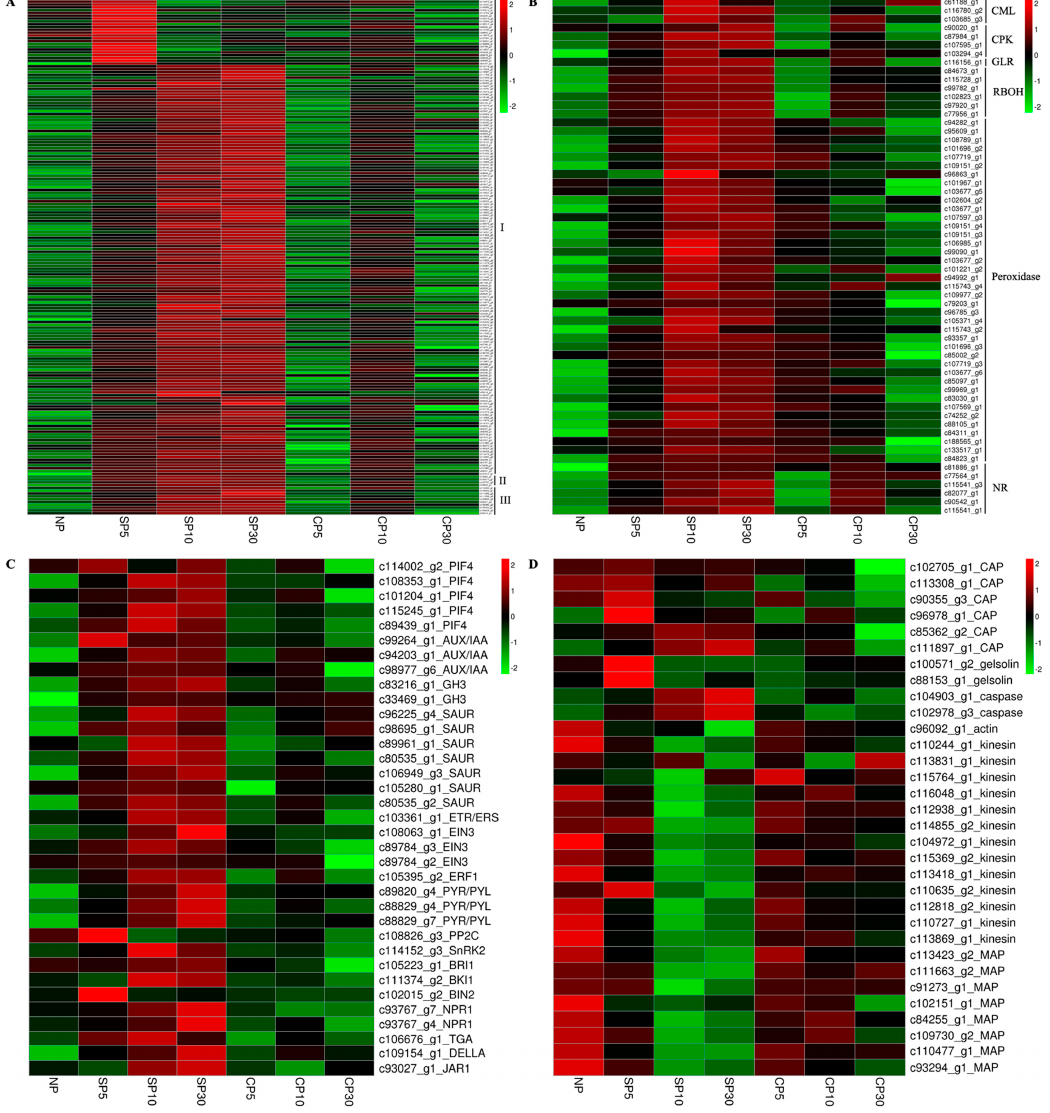
Figure 7. Expression profiles of selected SI response gene categories. ( A ) Protein phosphorylation (I) and putative pollen (II)–stigma (III) recognition-related genes. ( B ) Calcium (Ca 2+ ), reactive oxygen species (ROS), and nitric oxide (NO) signaling-related genes. ( C ) Plant hormone signaling-related genes. ( D ) Cytoskeleton-related genes. NP, nonpollination; SP, self-pollination; and CP,